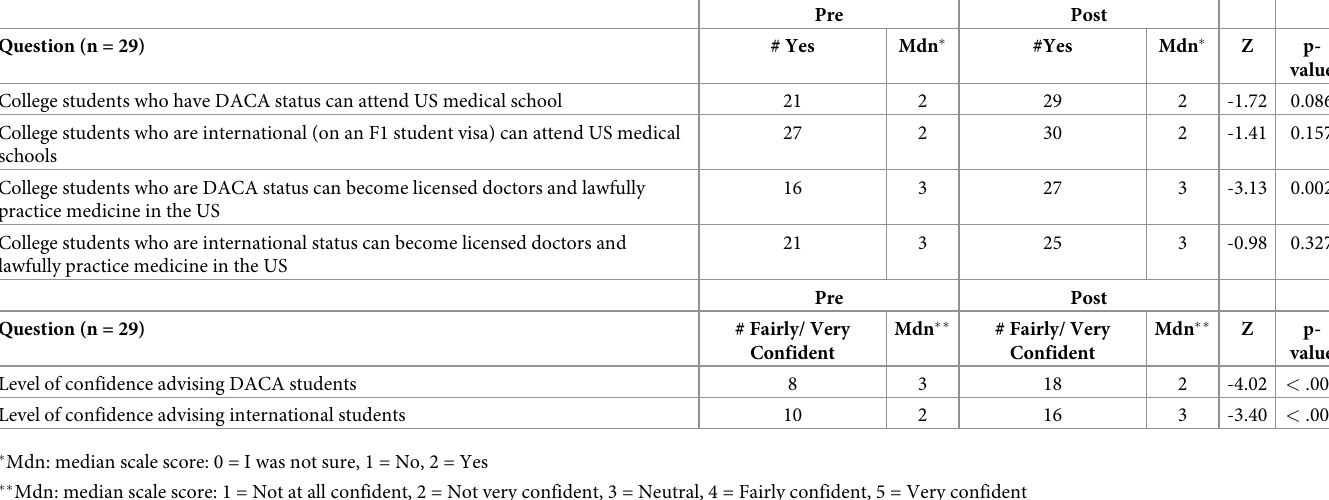
Table 2. Pre-post survey results following program on supporting DACA recipients and international students in medicine.